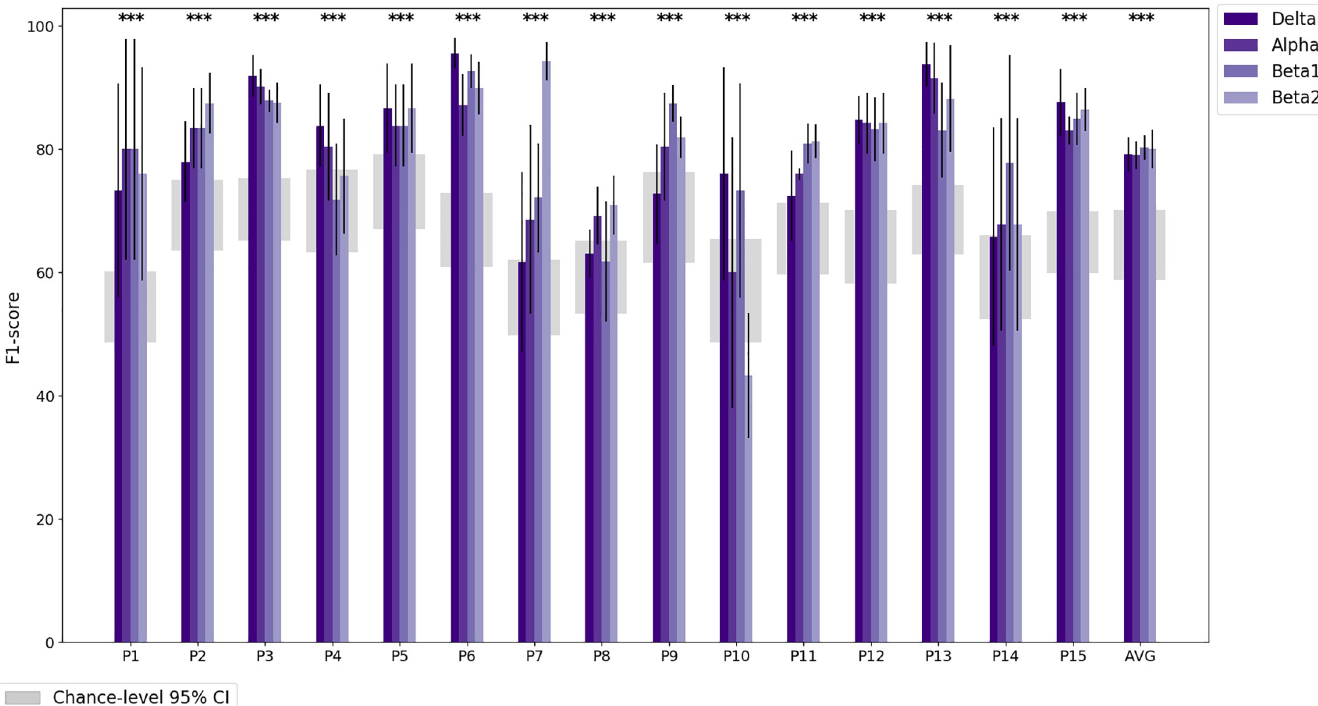
Fig 6. Classification performance for the Artifacts Present approach given by the F1 score for each participant and frequency band. The rightmost set of bars are the averages across participants. Standard error bars are given for five cross-validation runs for each participant and all 15 participants for the averaged accuracies. The 95% confidence intervals for chance-level F1 scores per participant are plotted as grey regions, and statistical significance is calculated using independent two-sample t- tests using the best frequency band. � : p < 0.01, �� : p < 0.001, ��� : p < 0.0001.